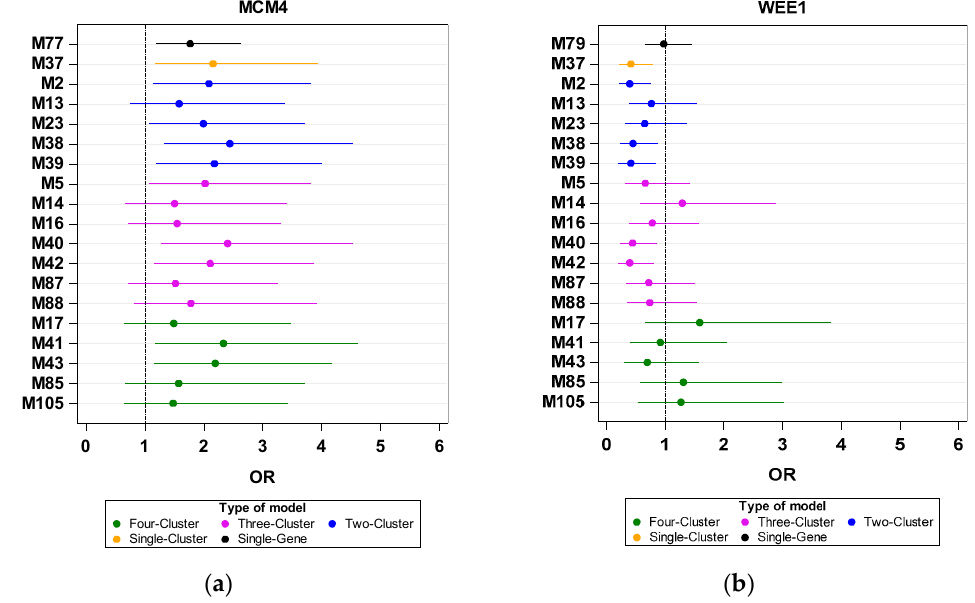
Figure 4. Odds ratios (ORs) of investigated genes based on single-gene, single-cluster, and multiple- cluster analyses. The X- and Y-axes are the OR and Model ID, respectively. ( a ) MCM4 and ( b ) WEE1. Fifth, ZNF264 /TRf and RNF4 /TRf were oppositely affected by CY- or LY/CY-contain- ing models in the three-cluster analysis (M40, M88, and M41; Figure 5). The CY-derived negative effect on ZNF264 /TRf was partially reversed by the coexistence of TLA/SN (M85); however, the LY/TLA/SN set suppressed the PS of ZNF264 /TRf (M20). In addition, the TLA cluster eliminated the SN-derived positive influence on the PS of RNF4 /TRf (M6 vs. M11).